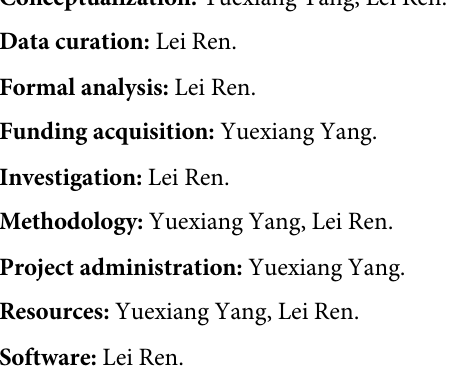
S1 Table. Relative nearness degree and rank of 30 provinces from 1999 to